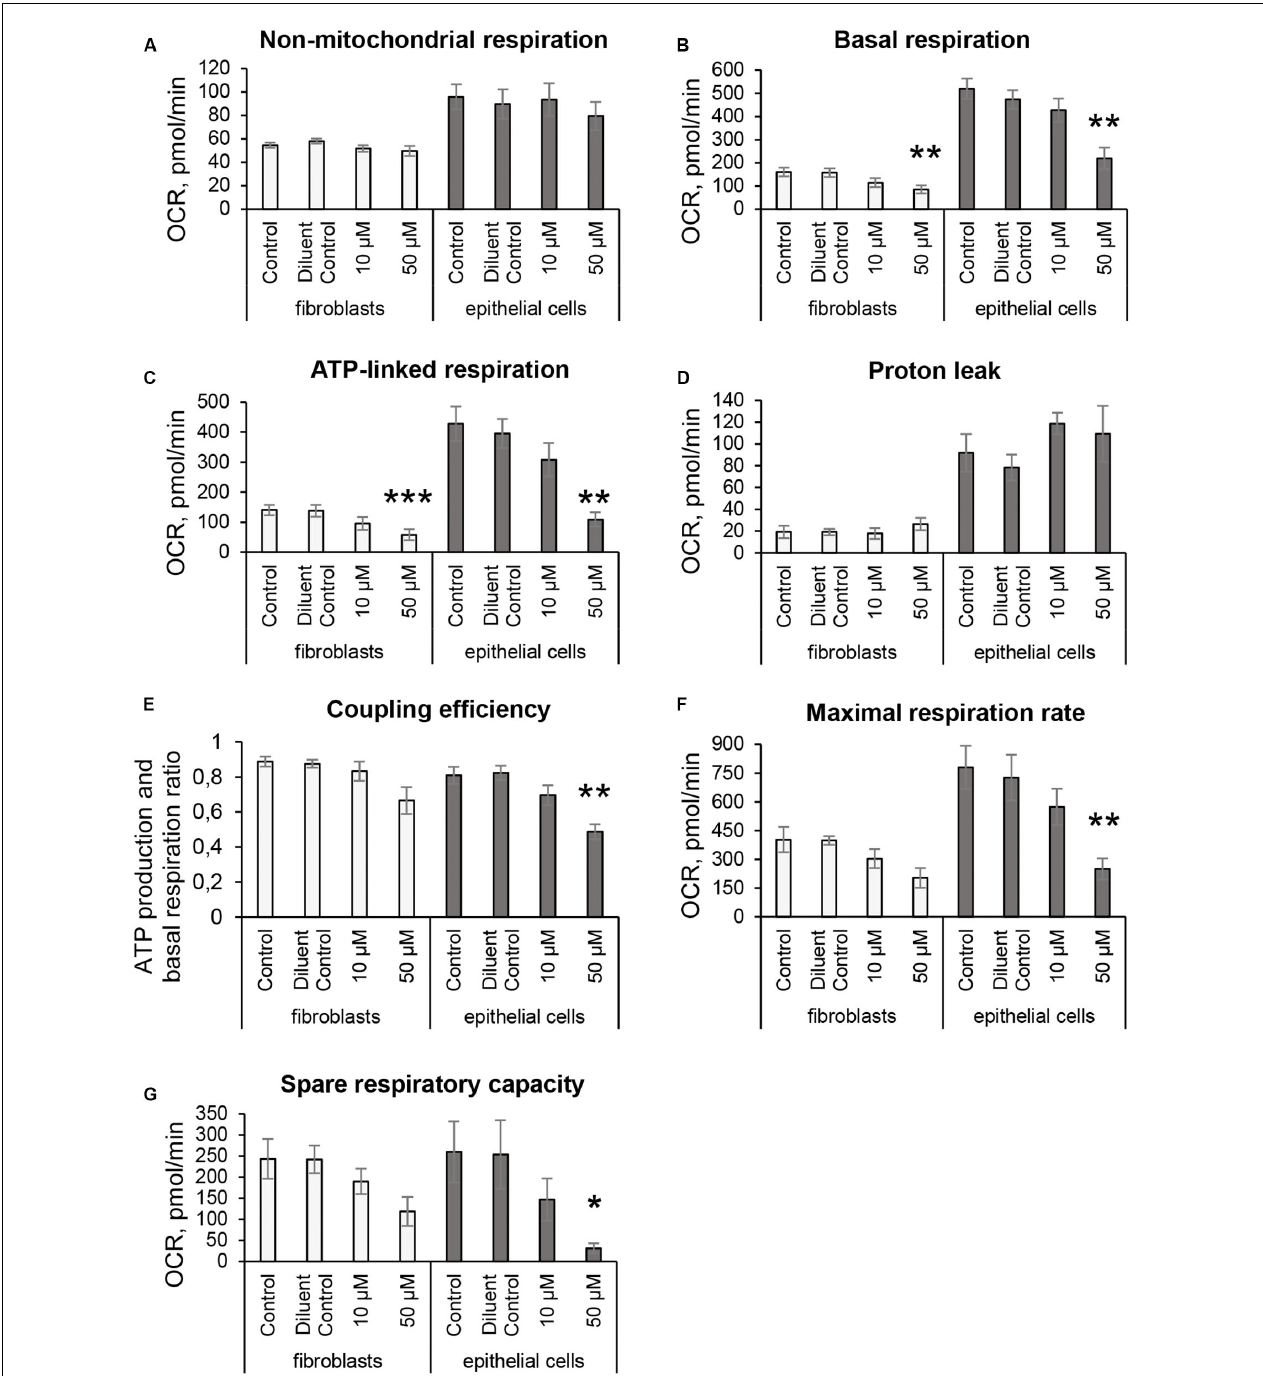
FIGURE 6 | Mitochondrial respiratory activity in fibroblasts and intestinal epithelial Caco-2 cells in response to 3O-C 12 -HSL. Cells were either untreated (Control) or treated with 0.02% DMSO as a diluent (Diluent Control), or 10 and 50 µ M 3O-C 12 -HSL for 3 h and then analyzed using the Seahorse XF24 Analyzer and Cell Mito Stress Test assay to study key characteristics of respiration and mitochondrial function. OCR levels (pmol/min) were measured in real time, first as baseline, and then in response to adding modulators (as shown in Figures 1A,B ) that target different components of ETC in the mitochondria. (A) Non-mitochondrial respiration. (B) Basal respiration. (C) ATP-linked respiration. (D) Proton leak. (E) Coupling efficiency. (F) Maximal respiration. (G) Spare respiratory capacity. Columns represent the mean ± SE. Significant differences are indicated with * P < 0.05, ** P < 0.01, and *** P < 0.001, as analyzed by a paired two-tailed Student’s t -test, compared to the diluent control. White columns represent data on fibroblasts based on three independent experiments done in 3–5 replicates and on separate days with different cell passages. Gray columns represent data on intestinal epithelial monolayers based on five independent experiments done in 3–5 replicates on separate days with different cell